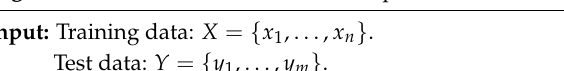
Algorithm 1 . The combination of incomplete